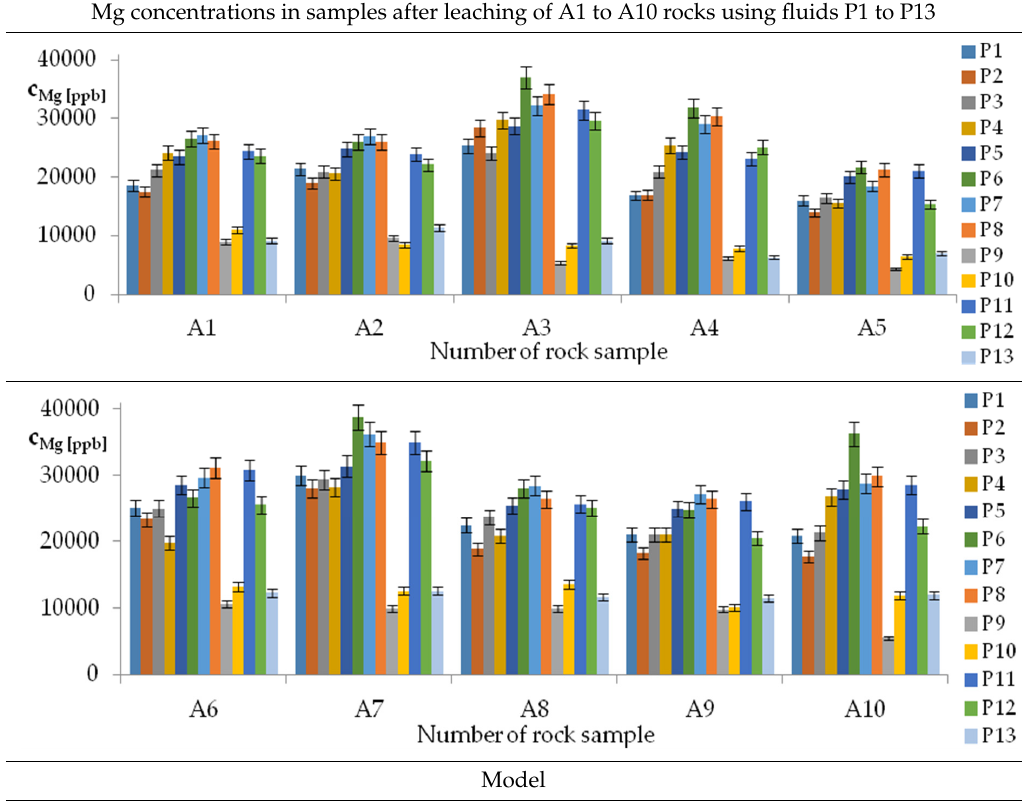
Table 12. Results of leaching samples A1 to A10 rocks using fluids P1 to P13 for Magnesium (Mg). Mg concentrations in samples after leaching of A1 to A10 rocks using fluids P1 to P13